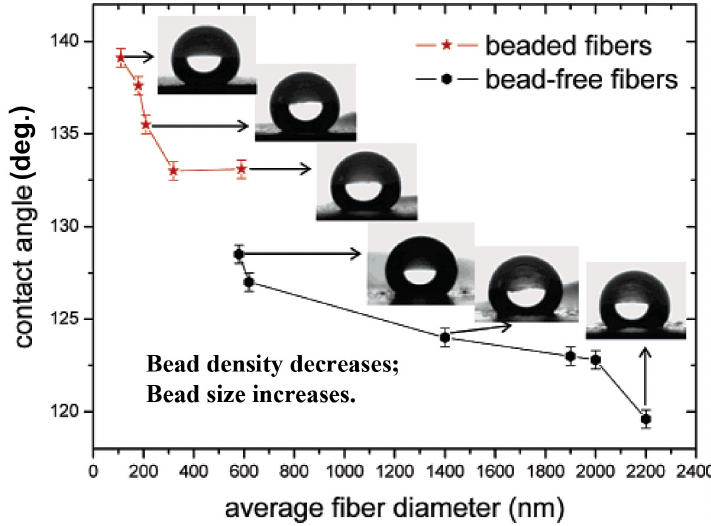
Figure 17. Effect of fiber’s diameter on static contact angle. From Ma et al.